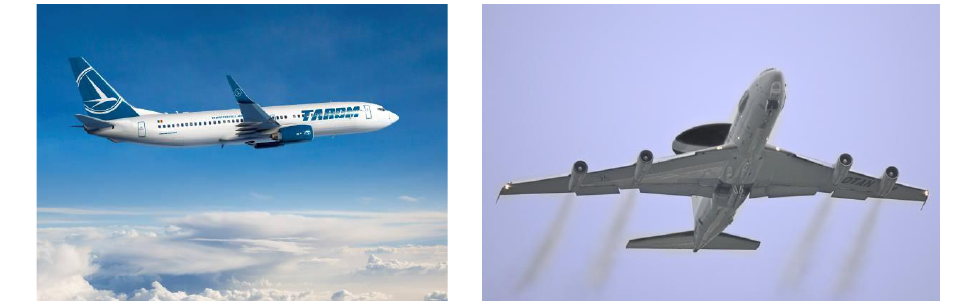
Figure 6 – Smoke trails (“Foto- Fetischistin”, 2010)